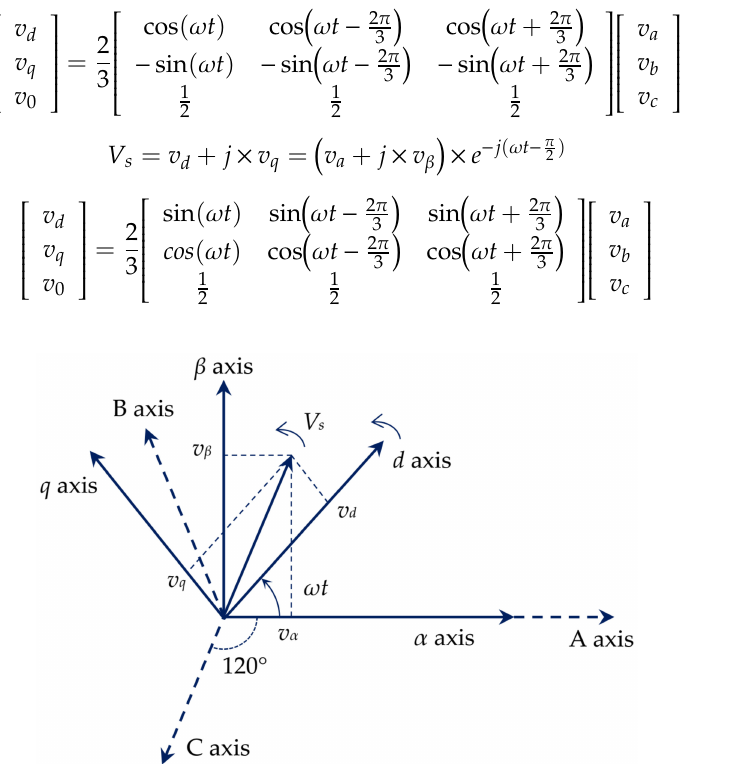
Figure 7. Phasor diagram d-q axis